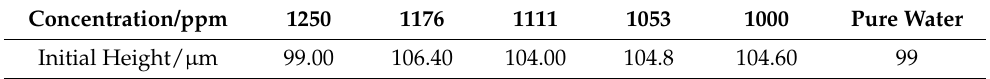
Table 3. Average initial droplet height of thiophanate-methyl with different concentrations.